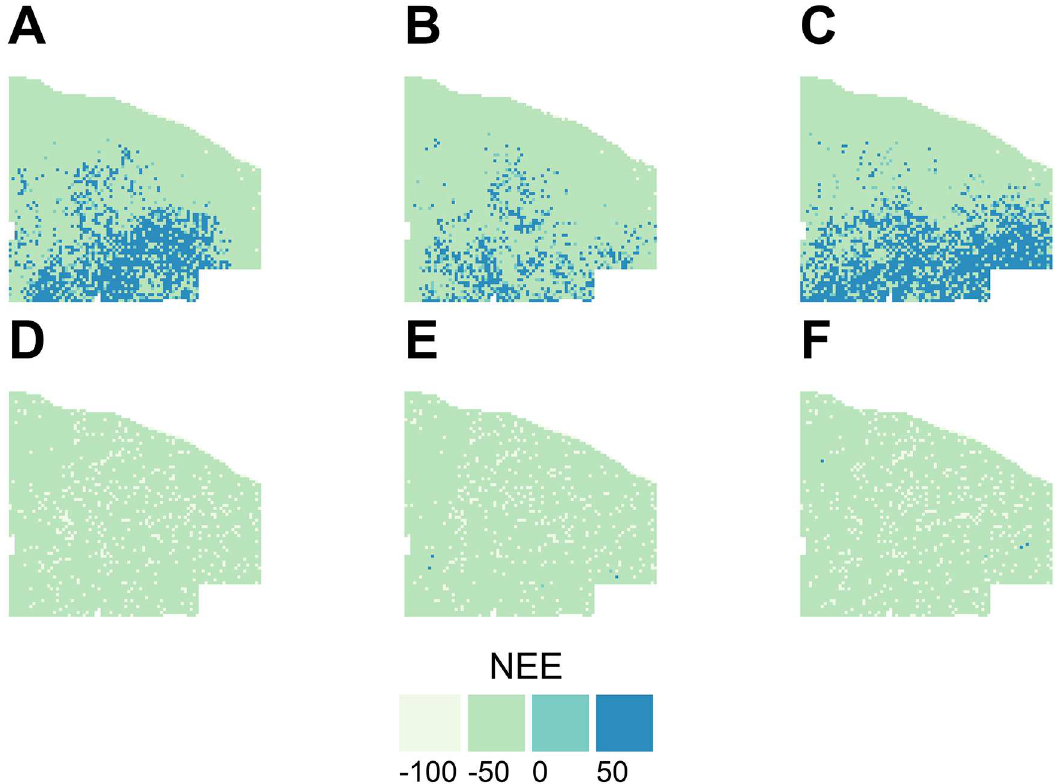
Fig 5. Mean cumulative net ecosystem exchange (NEE, Mg C ha -1 ) from 15 replicate simulations for the control 2010–19 climate (A), control 2050–59climate (B), control 2090–99climate (C), thin and burn 2010–19climate (D), thin and burn 2050–59 climate (E), thin and burn 2090–99climate (F) with the samewildfire parameterization over the 100-yearsimulation period. Negativevalues indicate a sink and positive values a source of carbonto the atmosphere. Bin rangesare -100 ( (cid:20) -100), -50 (-100 < -10), 0 (-10 (cid:20) 10), 50 ( > 10).